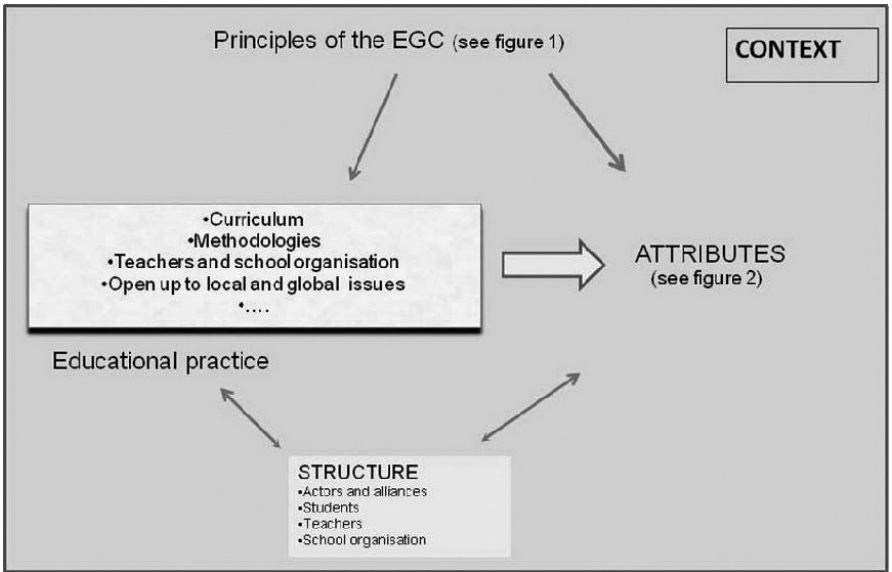
Figure 3: Elements of the quality